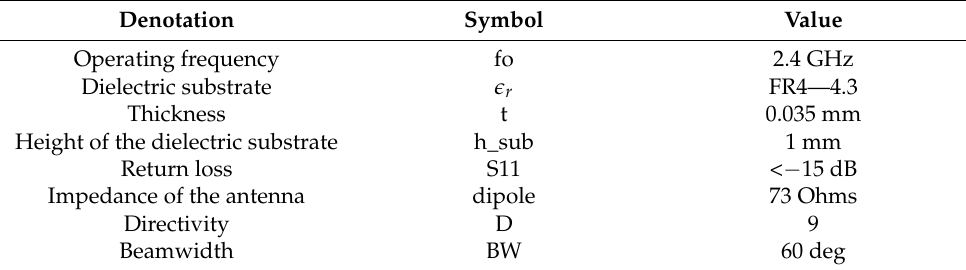
Table 2. Element Design Requirement. Table 3. Dipole results.